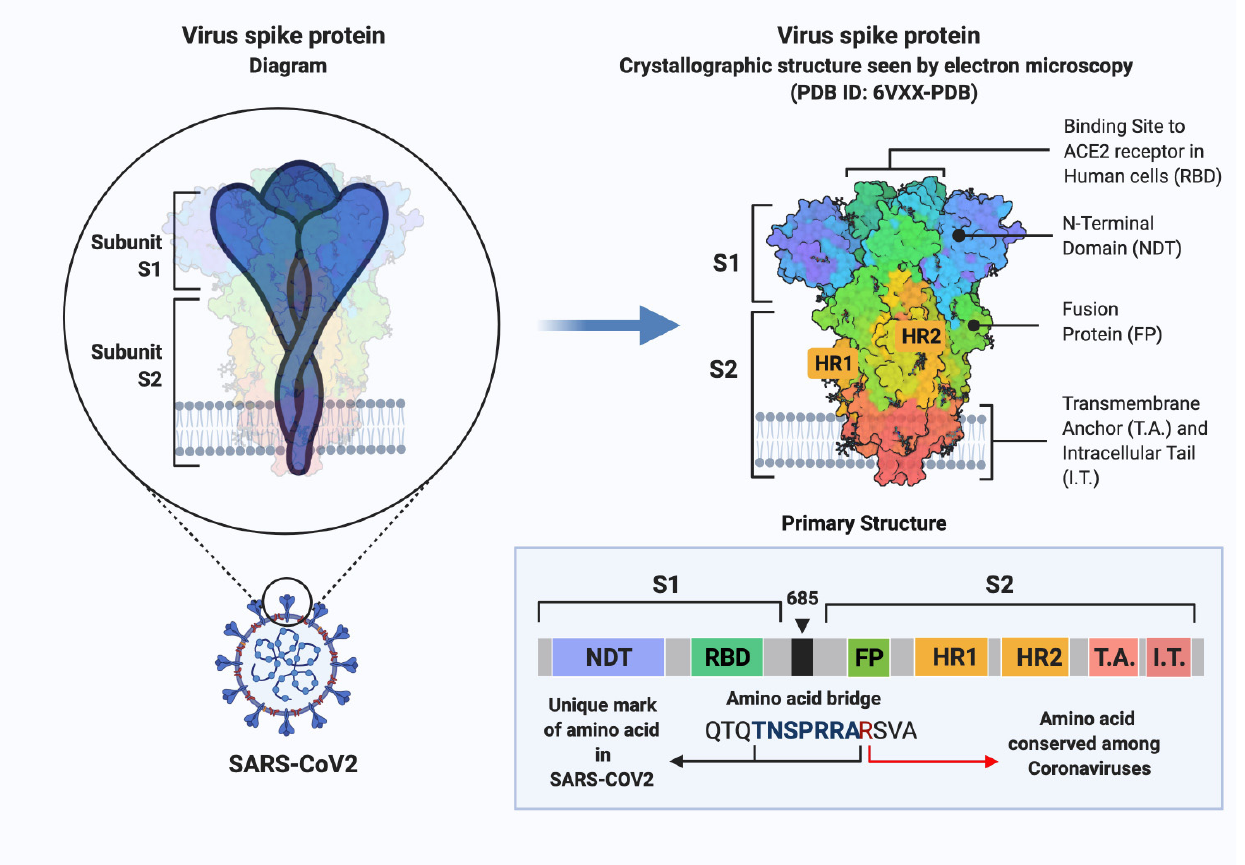
Figure 3. Schematic representation of SARS-CoV-2 spike protein primary structure. Domains are depicted with different colors. NTE, N-terminal domain; RBD, receptor-binding domain; FP, fusion peptide; HR1, heptad repeat 1; HR2, heptad repeat 2; TM, transmembrane domain; IT, intracellular tail. Created with BioRender.com.